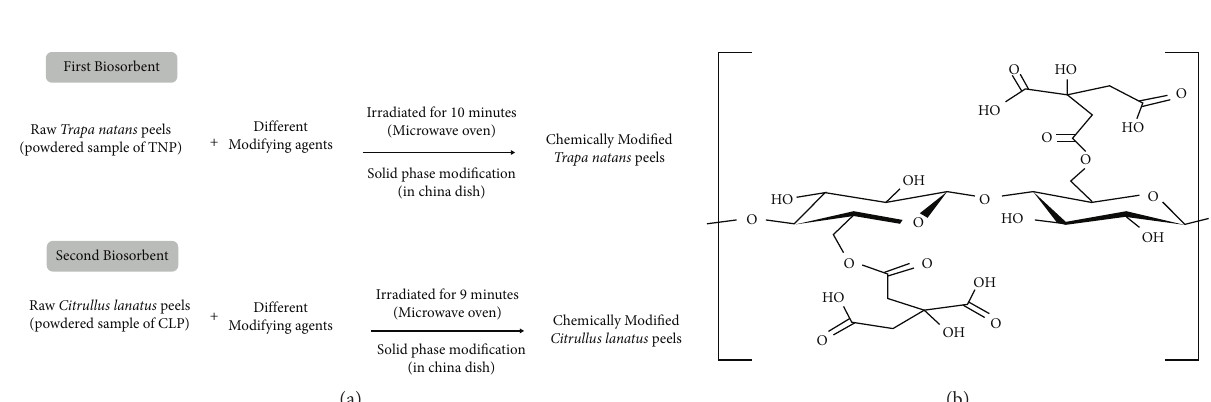
Figure 2: (a) Scheme of chemical modification of peels. (b) Scheme of chemical-modified adsorbent (CA-TNP and CA-CLP).